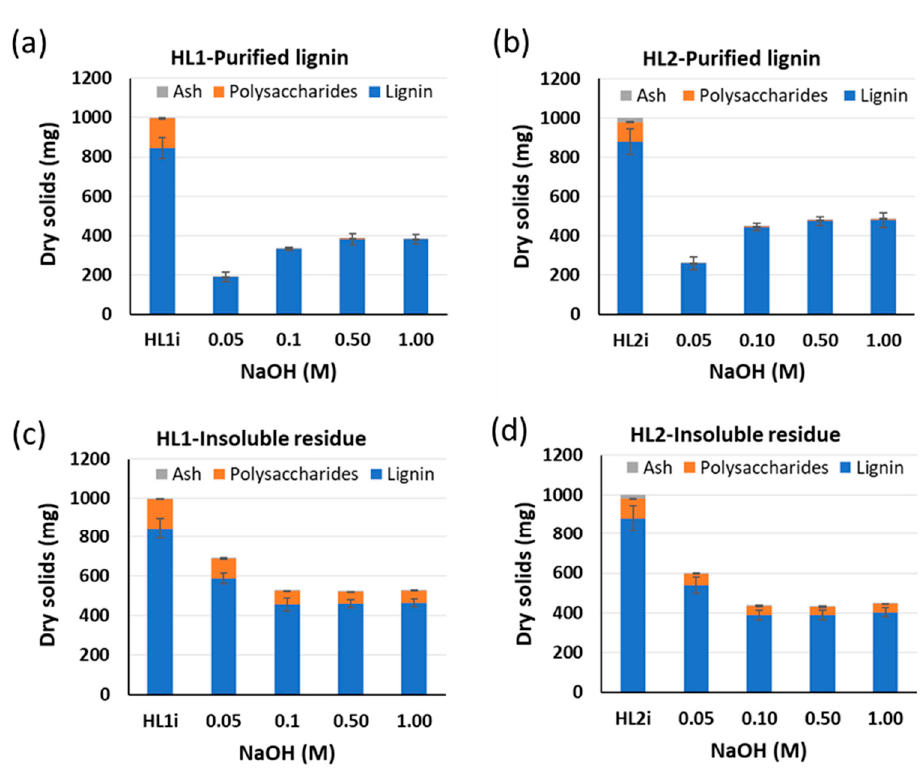
Figure 1. Influence of NaOH concentration on the composition of purified lignin (PL) for ( a ) HL1 and ( b ) HL2 lignins and insoluble residue (IR) for ( c ) HL1 and ( d ) HL2 lignins. Experiments are using initial W lign = 0.03 and T = 25 °C. HL1i and HL2i represent the initial lignins before treatment. Standard deviation error bars of duplicate experiments.